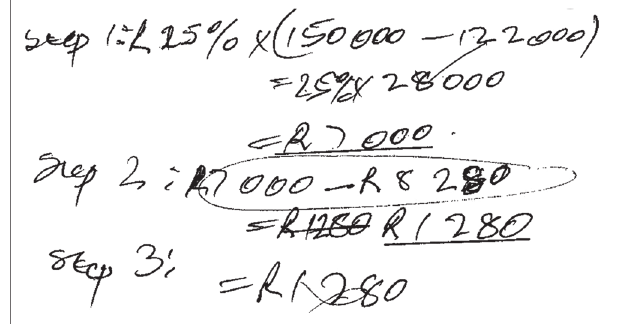
FIGURE 5: Response of MHL 630 to Task